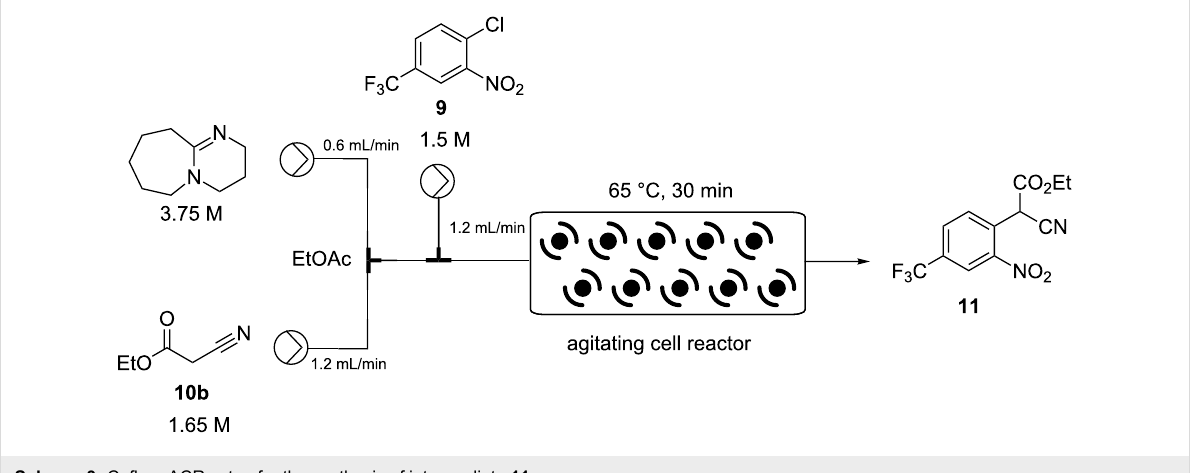
Scheme 3: Coflore ACR setup for the synthesis of intermediate 11 .